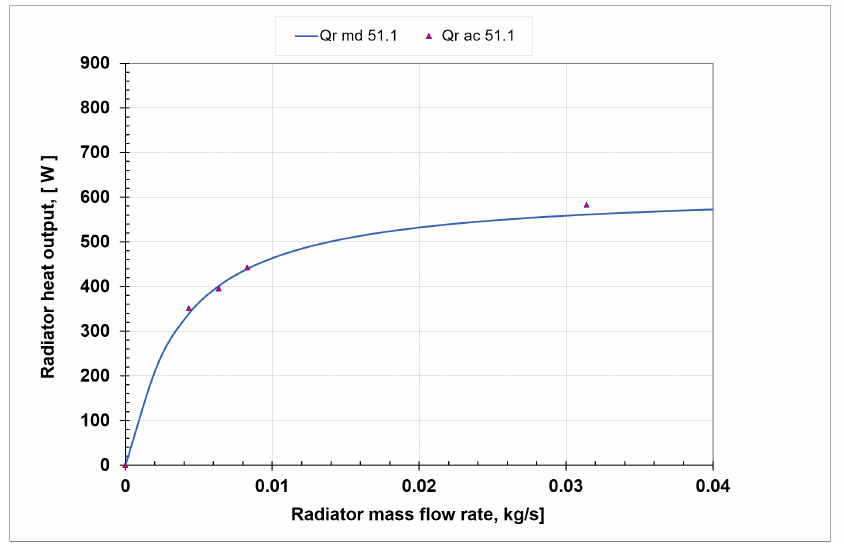
Figure 29. Comparison of the test and calculations results of the convection radiator type-8RR heat output change as a function of the mass flow rate, t s = 51.1 ◦ C. The comparison between the measurement and simulation calculations result of the convector radiator type-8RS heat output, with extended external surface (ribbed degree around 22.1) according to the NEHTMiR md at t s = 58.8 + − 0.2 ◦ C and radiator water mass flow rate from 0.0035 kg/s, 26% (nominal) value to 0.0226 kg/s, 168% (nominal) value are presented on the Figure 30 . The difference between the actual heat output of the convector radiators with extended external surface (ribbed degree around 22.1) and calculated according to the NEHTMiR md do not exceed